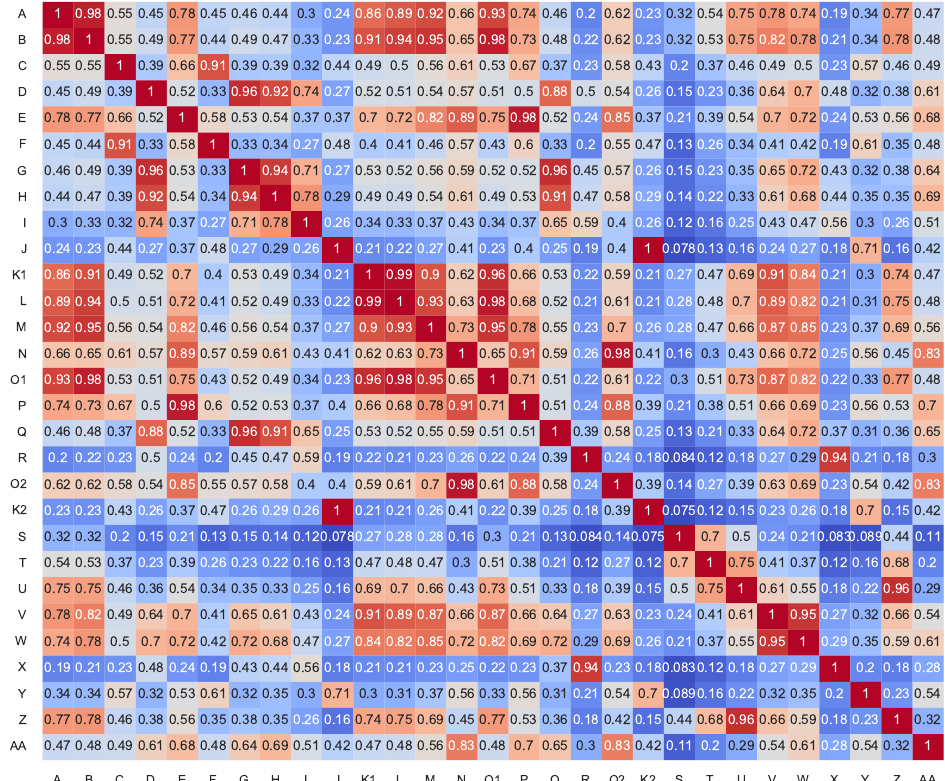
Figure 10. Correlation matrix of generated power of considered wind farms. Shown are pairwise correlation coefficients, each calculated from the two vectors of hourly production data from the re- spective sites. Again, for clearer representation, the matrix elements are colored from dark blue (correlation is equal to − 1) to dark red (correlation is equal to 1).